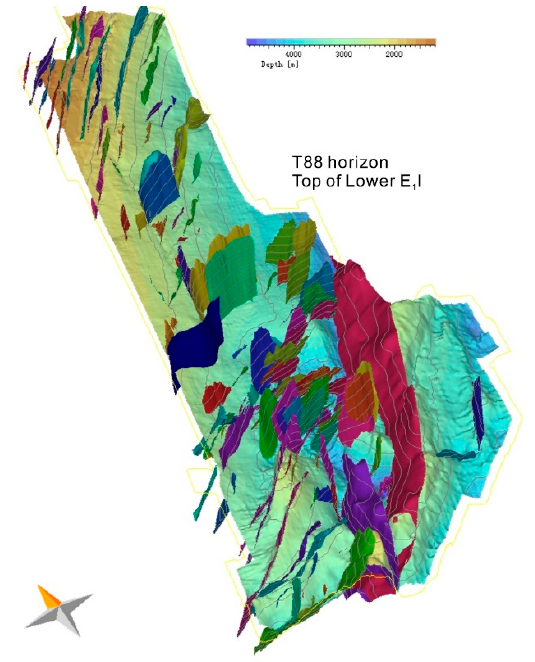
Figure 5. Model faults in the study area intersect with the stratigraphic surface. The surfaces with unique colors are faults and the stratigraphic horizon refer to the top surface of Lower E 1 l. Because of the lithologic variability of the mixed sandstone and mudstone reservoirs, uniform compositions are inadequate for the accuracy required by the basin model. As shown in Table 2, the physical properties of rock vary widely in the E 1 m and E 1 l, and there was also a significant difference between the upper and lower layers. We used Athy’s Law [35,36] and core measured porosity data to calibrate the porosity versus depth curve of Upper and Lower E 1 m and E 1 l and other formations. The algorithms and formula of the porosity are listed in Equation (1) and Table 2. The calibrated curves are shown in Figure 6 and the difference between sandstone and siltstone is clear. The correlations between permeability and porosity were also established using the measured data from the Lishui Sag (Table 1).